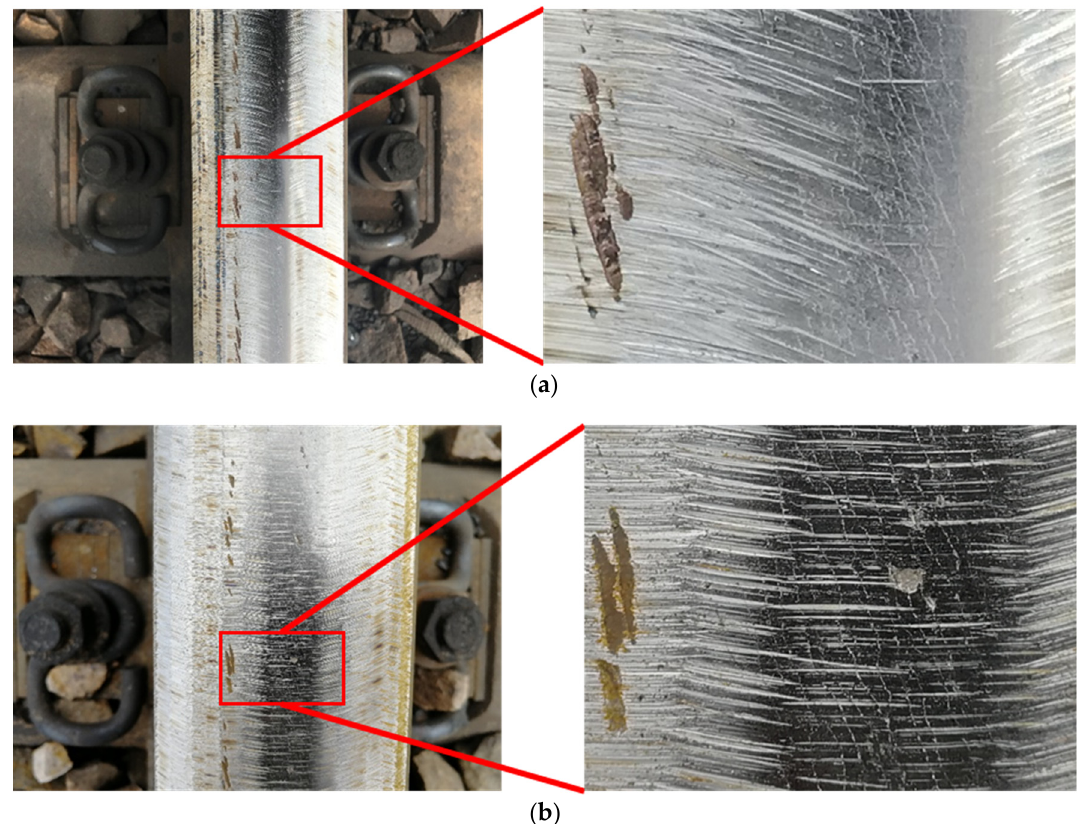
Figure 5. Railhead state after two times of grinding works: ( a ) cracks do not intersect with grinding marks after first grinding works; ( b ) cracks intersect with grinding marks after second grinding works with poor grinding quality.